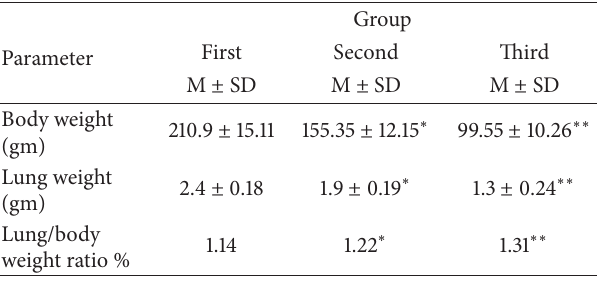
Table 1: Comparison between effects of cyclosporine different doses on the rats’ lung weight, body weight, and the lung/body weight